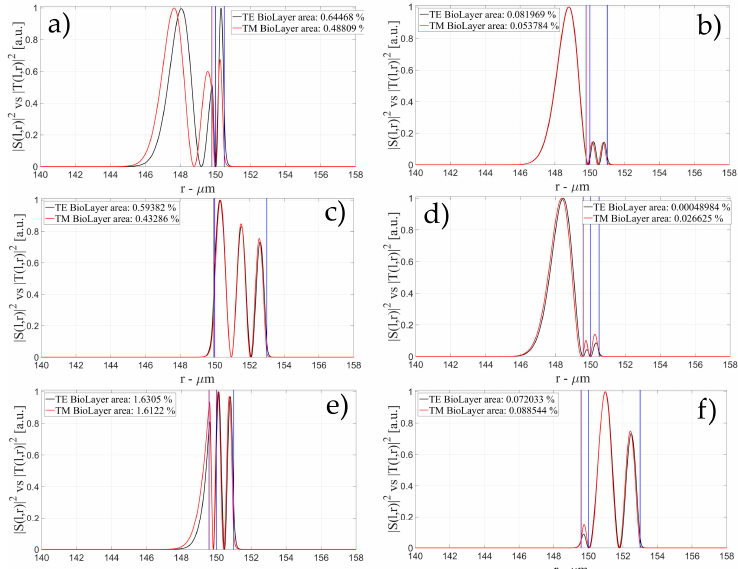
Figure 14. Electric field distribution of WGMs along the radial direction for TE (| S ( l,r ) | 2 ) and TM (| T ( l,r ) | 2 ) modes for the 3rd radial order: ( a ) for a wall of about 500 nm and a polymer thickness of about 200 nm; ( b ) for a wall of about 1 μ m and a polymer thickness of about 200 nm and ( c ) for a wall of about 3 μ m and a polymer thickness of about 200 nm; ( d ) for a wall of about 500 nm and a polymer thickness of about 400 nm; ( e ) for a wall of about 1 μ m and a polymer thickness of about 400 nm and ( f ) for a wall of about 3 μ m and a polymer thickness of about 400 nm Legends show the fraction of | S ( l,r ) | 2 and | T ( l,r ) | 2 inside the biological layer.